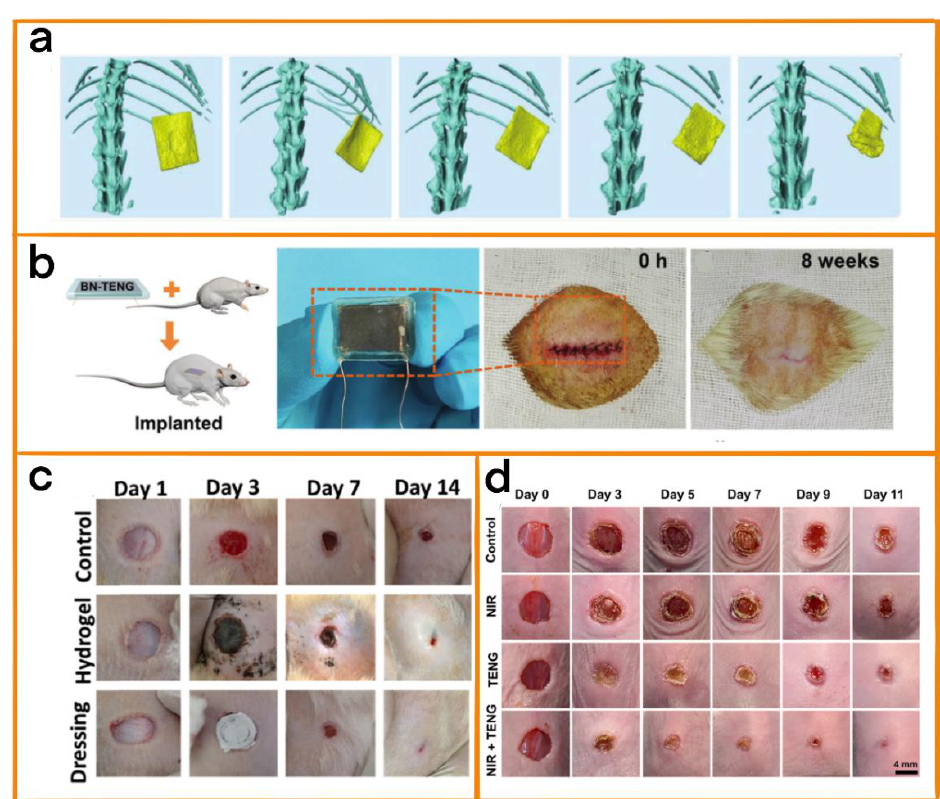
Figure 10. ( a ) Biodegradation in rats. ( b ) BN-TENG implantation: pictures of BN-TENG and the change in state at the site of implantation after suture. Reprinted with permission from [81]. 2018, John Wiley and Sons. ( c ) Representative images of wounds on days 1, 3, 7, and 14. Reprinted with permission from [82]. 2022, Elsevier. ( d ) Images of skin wounds from different treatment groups taken on days 0, 3, 5, 7, 9, and 11. Reprinted with permission from [83]. 2022, Elsevier.